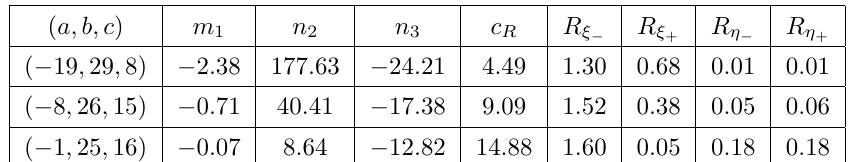
Table 3 . Values of m 1 ; n 2 ; n 3 ; c geo